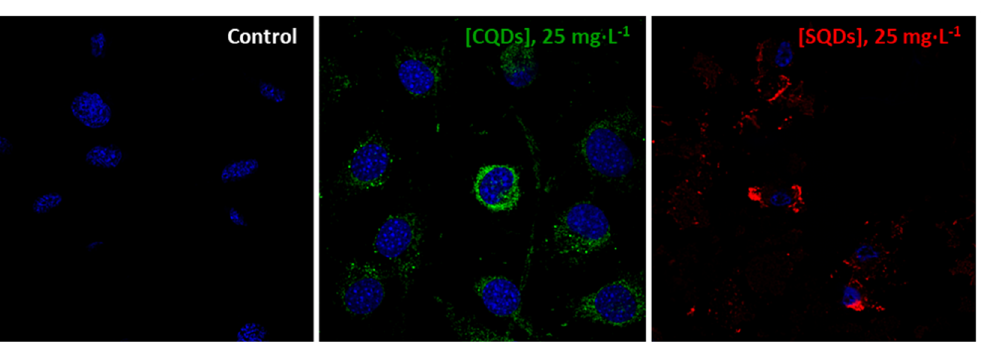
Figure 3. Confocal microscopy images obtained from 3T3-L1 cells exposed to 25 mg·L − 1 of CQDs or SQDs in the absence of serum for 24 h. Control cells were cultured in medium (DMEM) alone. Nuclei (blue) were stained with 4 ′ ,6-diamidino-2-phenylindole dihydrochloride (DAPI). iii. Cell uptake assay.